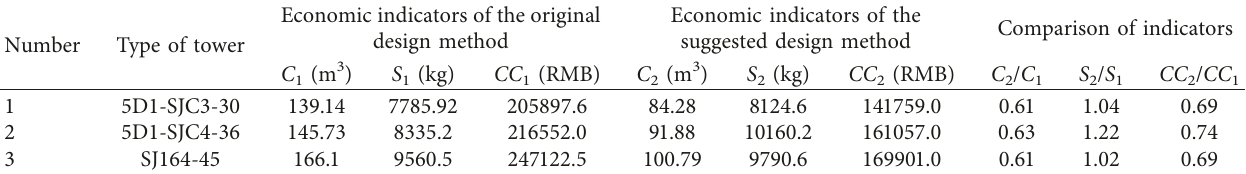
Table 13: Comparison of economic indicators between the original design method and the suggested design method.